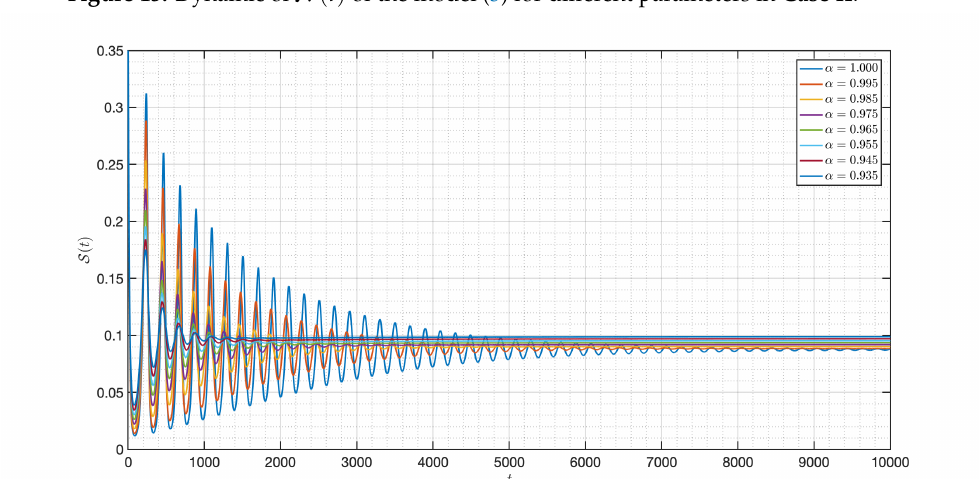
Figure 13. Dynamic of N ( t ) of the model (3) for different parameters in Case II .